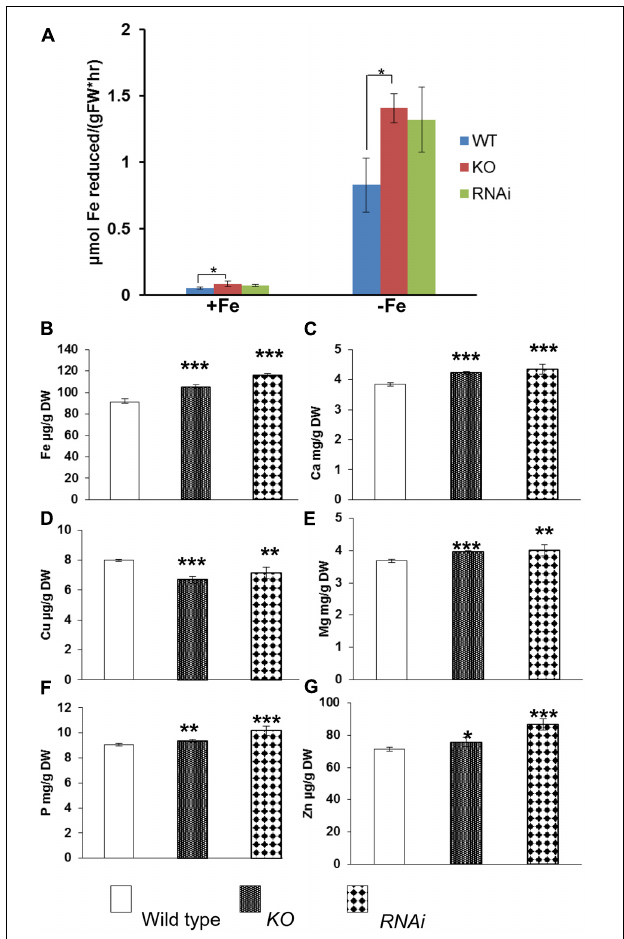
FIGURE 3 | Iron reductase assay and metal ion concentrations in wild type, atgrxs17 KO, and AtGRXS17 RNAi seeds. (A) , Wild type, atgrxs17 KO, and AtGRXS17 RNAi seeds were germinated and grown on 1 / 2 MS medium for 10 days, then transferred to iron sufficient or deficient medium for 3 days. Root ferric reductase activity was measured. Student’s t -test, n = 6, ∗ p < 0.05. (B–G) , Wild type, atgrxs17 KO, and AtGRXS17 RNAi seeds were germinated and grown in soil until mature. Seeds were harvested and dried. Whole seed Fe and other mineral concentrations were measured by inductively coupled plasma optical emission spectroscopy. Results represent the mean value of three independent replications. Student’s t -test, ∗ p < 0.05; ∗∗ p < 0.01; ∗∗∗ p <